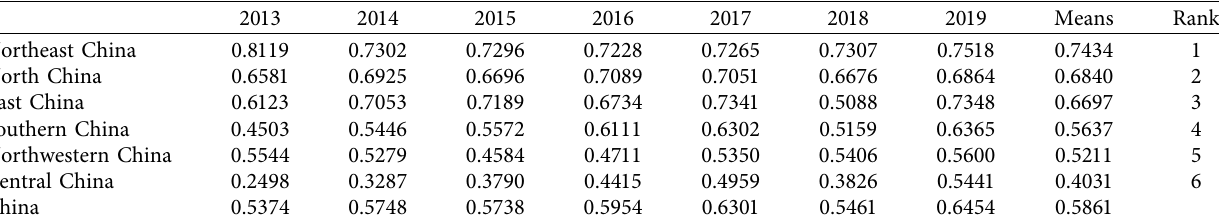
Table 3: Wind power utilization efficiency of six regions